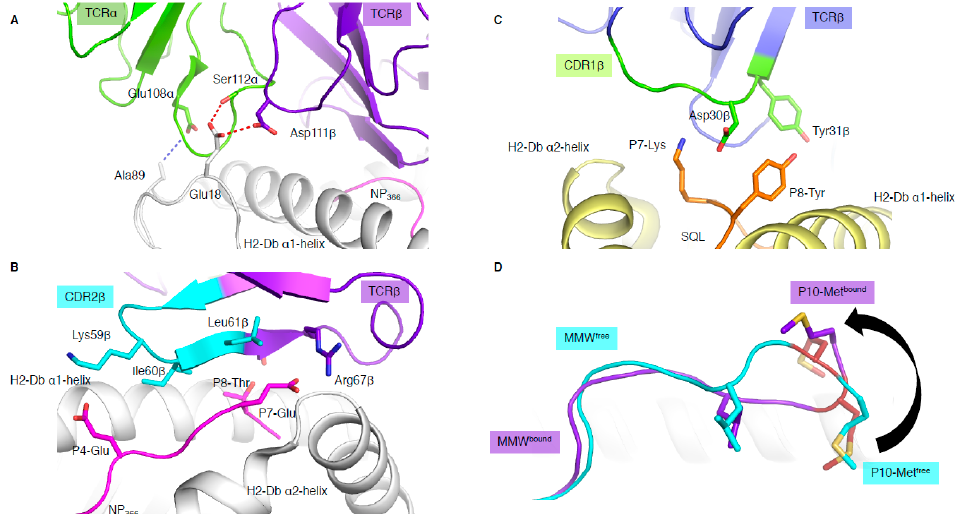
Figure 3. Unconventional TCR docking or TCR–peptide interactions . ( A ) NP2-B17 TCR ( α in green and β in purple) contacting the loops outside the H-2D b antigen-binding cleft, and, namely, the residues 18 and 89 (white stick). The red and blue dashed lines represent the hydrogen and Van der Waals interactions. ( B ) The NP2-B17 TCR CDR2 β (cyan) and framework β (purple) interact with the NP 366 peptide (pink) presented by H-2D b (white). ( C ) TRBV13-3+ TCR ( β chain in blue) with the CDR1 β (green) residues (sticks) interacting specifically with the malaria-derived SQL peptide (orange) P7-Lys and P8-Tyr (sticks) presented by the H-2D b (yellow). ( D ) Comparison of the MMW peptide structure (loop) presented by human leukocyte antigen (HLA)-A*02:01 without (cyan) or with the DMF5 TCR (purple). The DMF5 TCR binding leads to a register shift of the MMW peptide, whereby the P10-Met free in the HLA cleft (cyan sticks) is flipped out of the cleft (P10-Met bou nd in purple stick) upon binding of the DMF5 TCR.